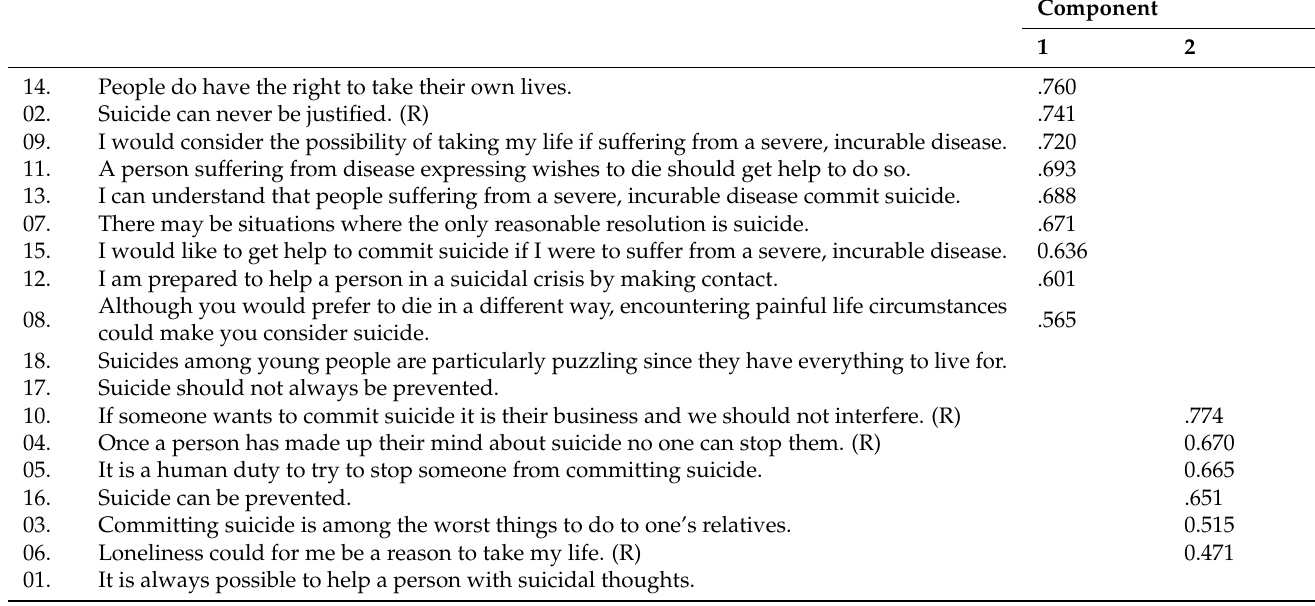
Table 1. Factor loadings for the 18 items of the